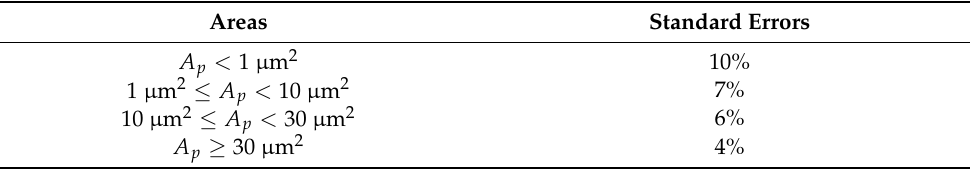
Figure 2. Schematical representation of the HV profiles ( a ) and 3 × 3 matrix ( b ) performed on the xz and xy planes of the bars, respectively. The build directions are: ( a ) parallel to the longer side of the bar, ( b ) perpendicular to the xy plane (i.e., on which the HV is measured). Table 4. Standard errors that are associated to each pore area analyzed